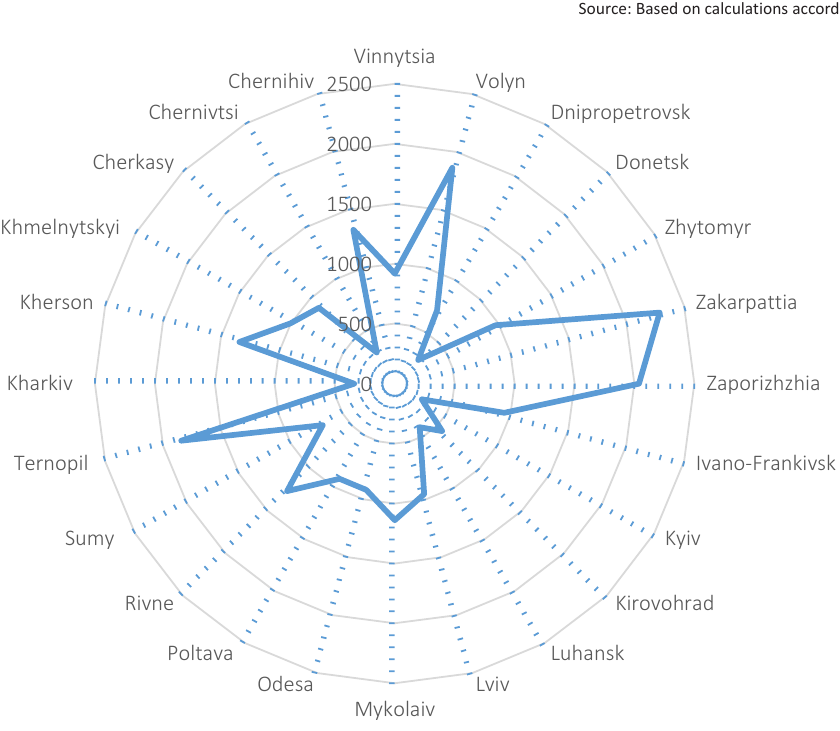
Figure 2. Indicators of the efficient regulation of land relations associated with the use of industrial land in built-up areas, together with the lease objects located on them, UAH/m 2